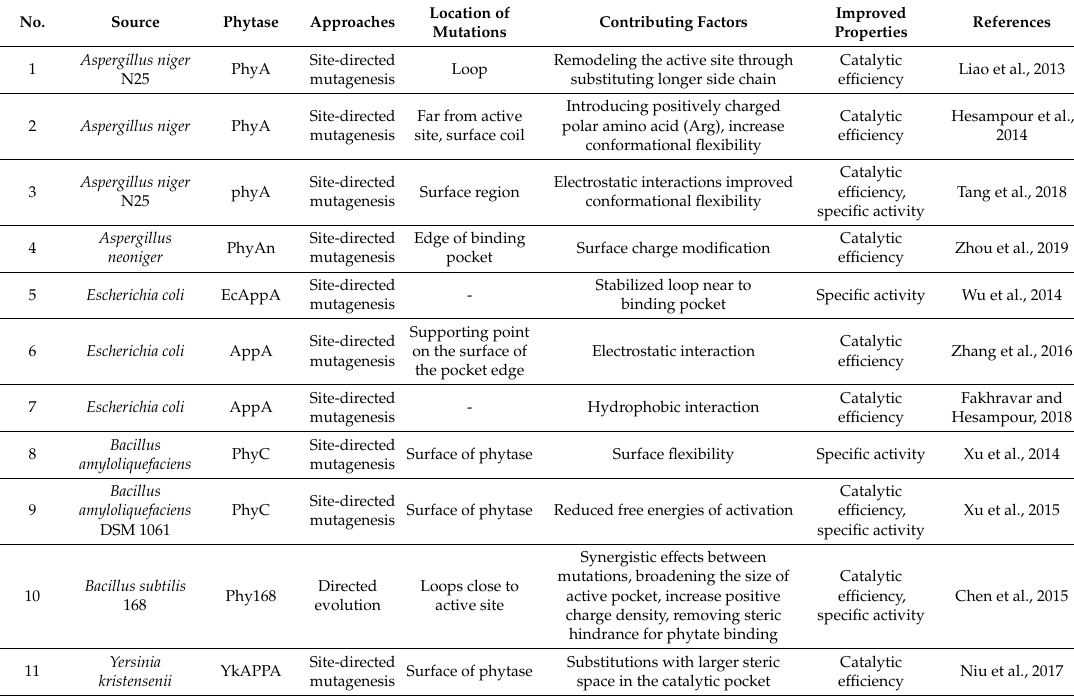
Table 4. Improvements of catalytic e ffi ciency and specific activity of various microbial